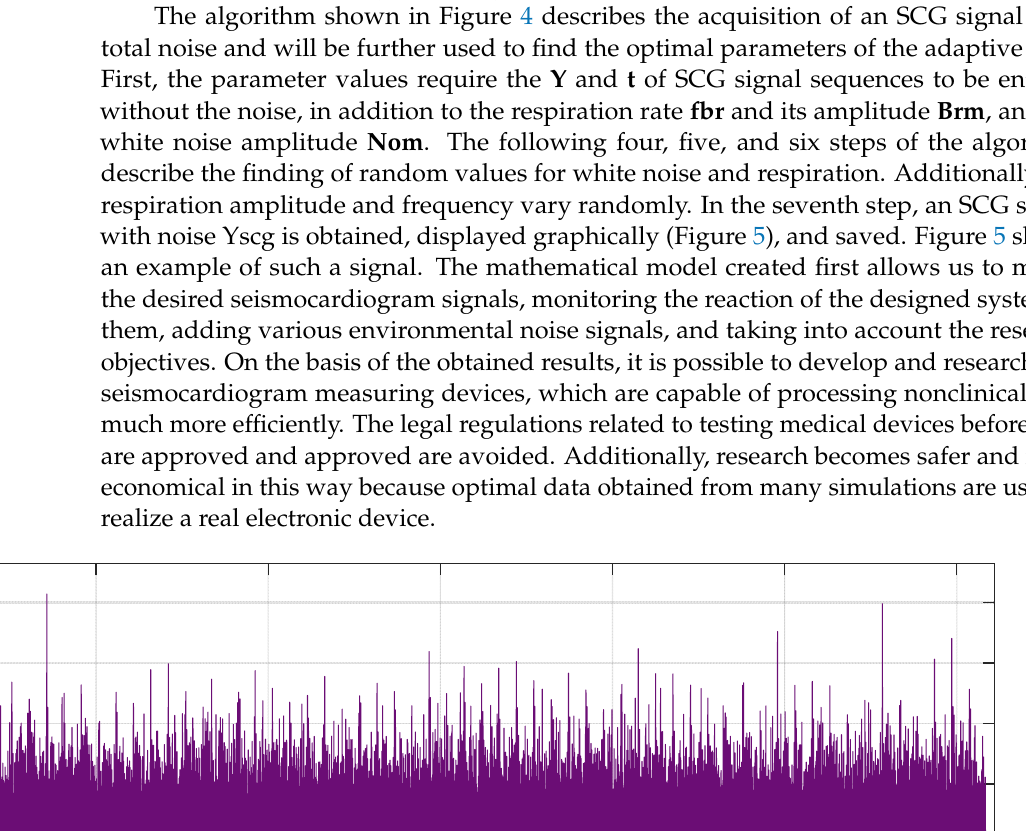
Figure 6. Position of accelerometer. Adaptive filtering has many advantages and is useful for biomedical applications when the filter coefficients self ‐ adjust to a rapidly and unpredictably changing signal. The principle of operation of the adaptive filter is defined by Equation (12) [43,44]. 𝑒(cid:4666)𝑛(cid:4667) (cid:3404) 𝑑(cid:4666)𝑛(cid:4667) (cid:3398) 𝑦(cid:4666)𝑛(cid:4667) (12) where: e ( n )—adaptation error, y ( n )—denoised signal in output, d ( n )—desired signal. The operation of this filter is based on the tendency of the filter output signal y ( n ) defined by Equation (13) to correspond as closely as possible to the affected signal d ( n ) through the feedback response of the error signal e ( n ) to the coefficients H(z) of the filter transfer function, so that e ( n ) is zero [43,44]. 𝑦(cid:4666)𝑛(cid:4667) (cid:3404) (cid:3533) 𝑏 (cid:3041) (cid:4666)𝑛(cid:4667)𝑥(cid:4666)𝑛 (cid:3398) 𝑘(cid:4667) (cid:3013) (cid:3038)(cid:2880)(cid:2869)